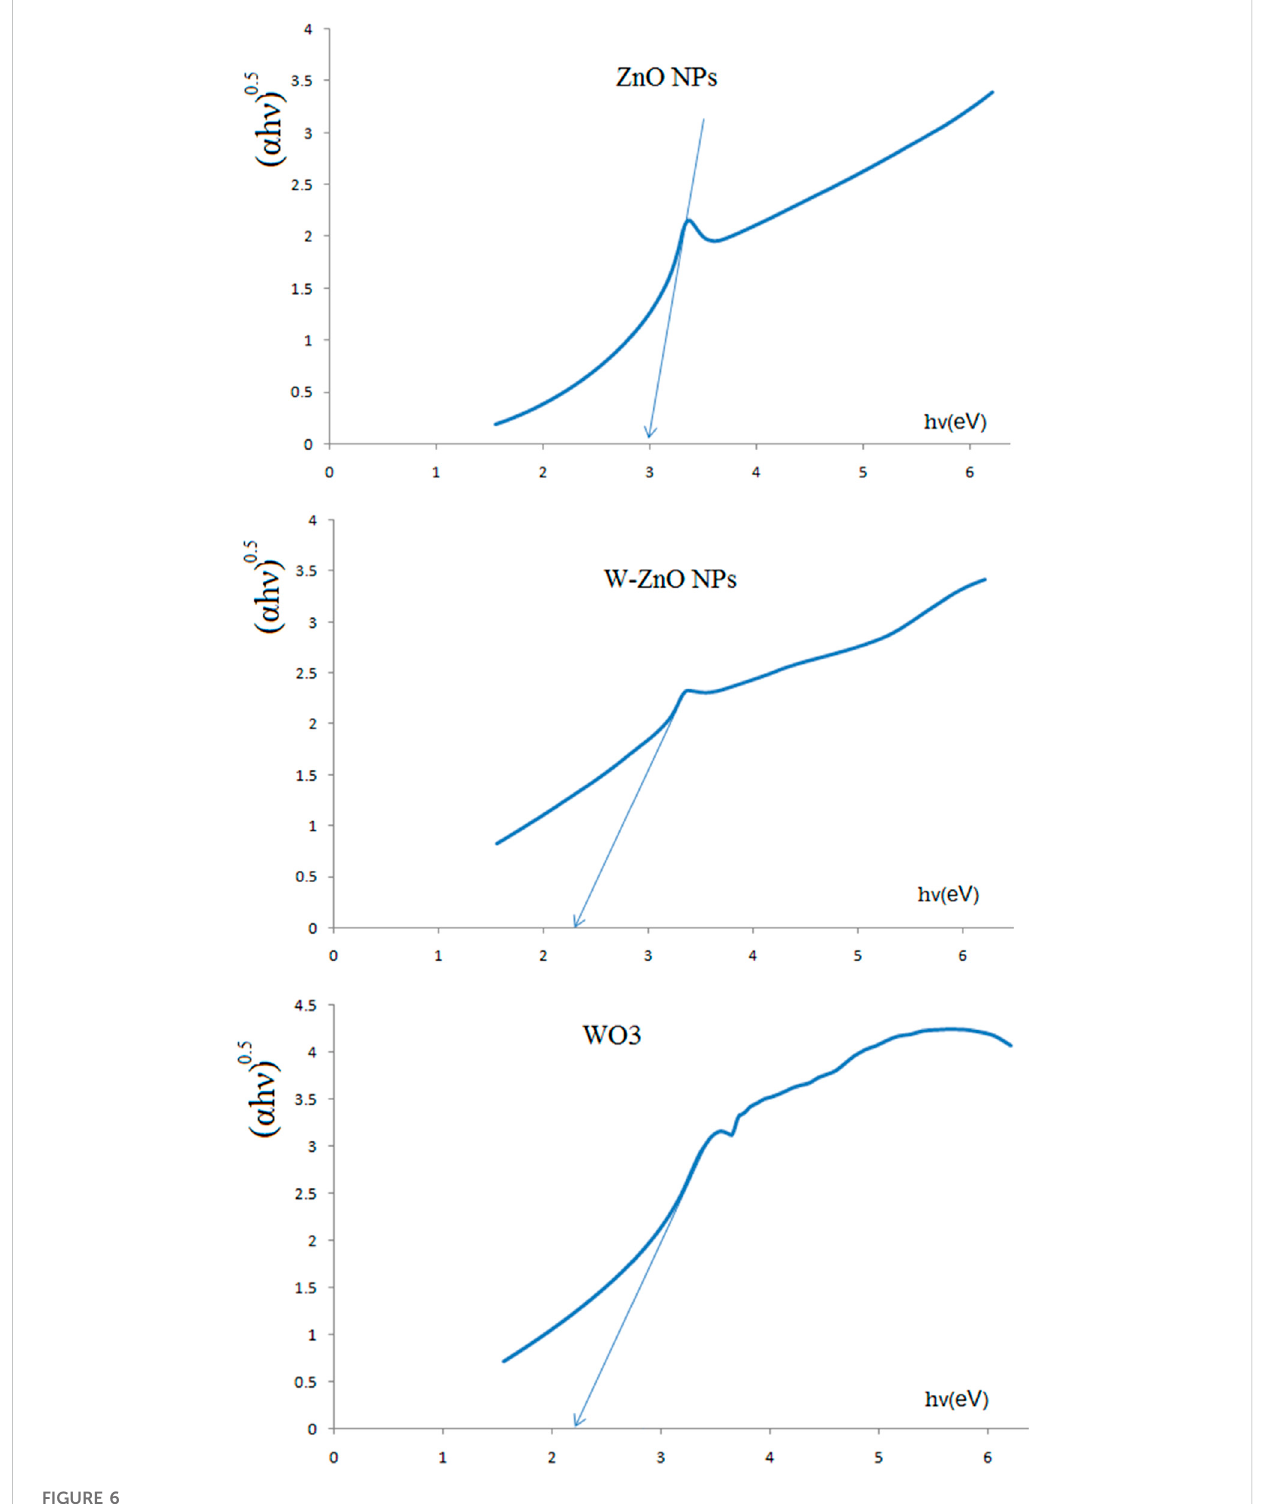
FIGURE 6 Tauc plots of ZnO, WO 3 and